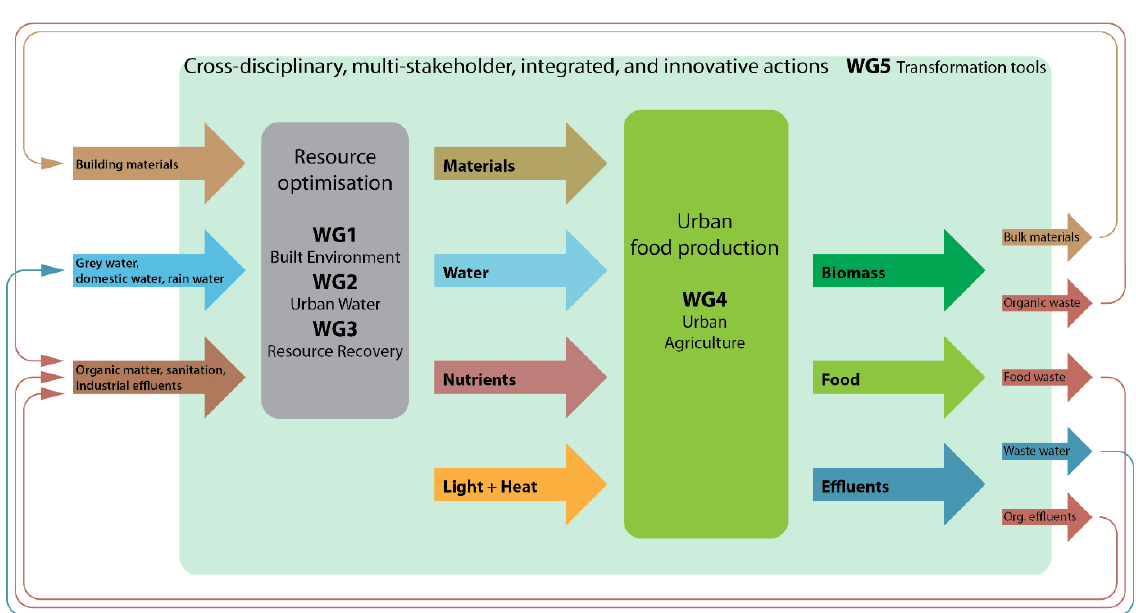
Figure 1. An urban agriculture centric view of the input and output streams studied within the working groups defined by the COST Action CA17133 Circular City on “Built Environment” (WG1), “Urban Water” (WG2), “Resource Recovery” (WG3), and “Urban Farming” (WG4) [7].